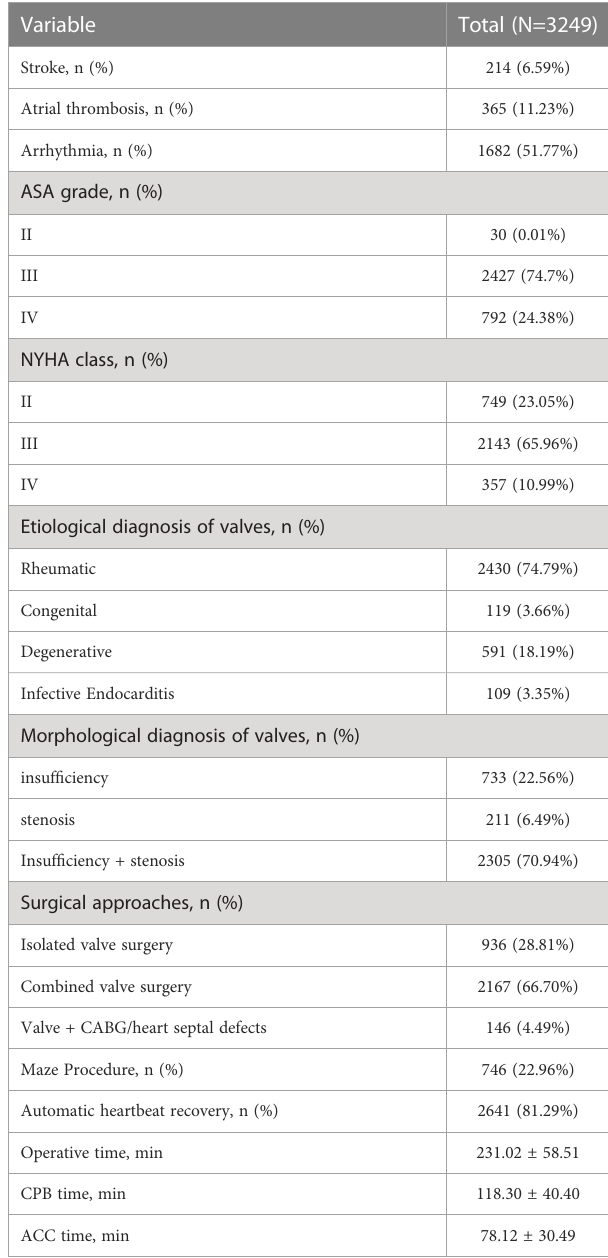
>400 pg/ml. In the multivariable logistic regression analysis (Table 3), CRP group ( P =0.001) with an RR=1.447